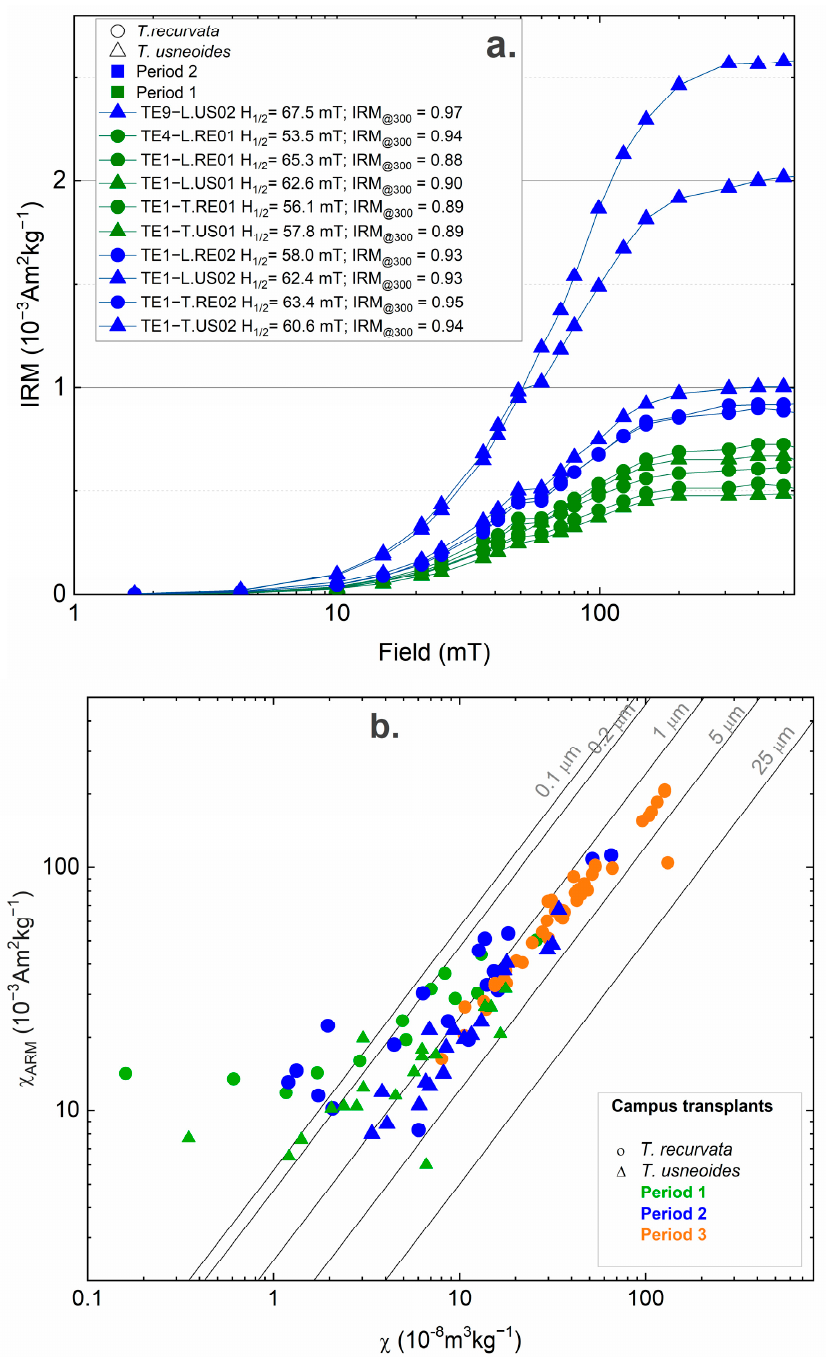
Figure 2. ( a ) Measurements of acquisition isothermal remanent magnetization for T. recurvata and T. usneoides . The IRM reaches saturation at 300 mT. The acquisition coercivity values are detailed. ( b ) Estimation of magnetic particle size for samples from every exposure period is based on the calibration lines of King’s plot [27].